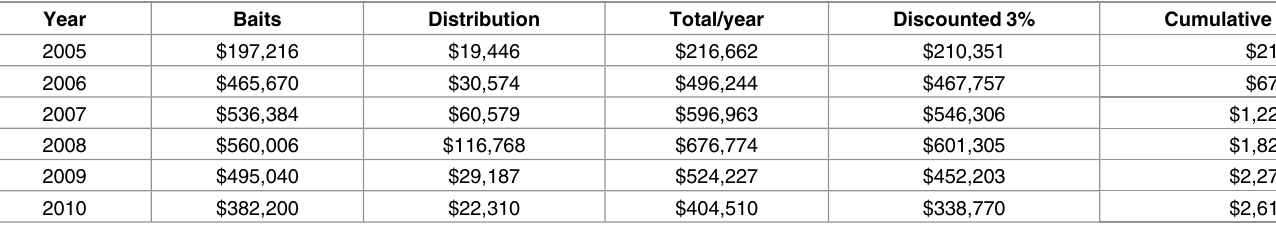
(BCRs). The cumulative BCR (benefit each year divided by the total cost) is projected to reach 1.71 in 2019, indicating every dollar spent on the ORV program will save $1.71 in costs. Sensitivity analysis revealed positive benefits and BCRs greater than one (Table 5), even when estimated PEP and AT rates were reduced by 40% (to 23.00 and 102.07, respectively), revealing that the benefits of the ORV program are robust to broad changes in model parame- ters. However, if PEP rates drop to levels seen in a previous epizootic in New York (12.1) [2], then this ORV program would no longer be economically efficient (BCR < 1).